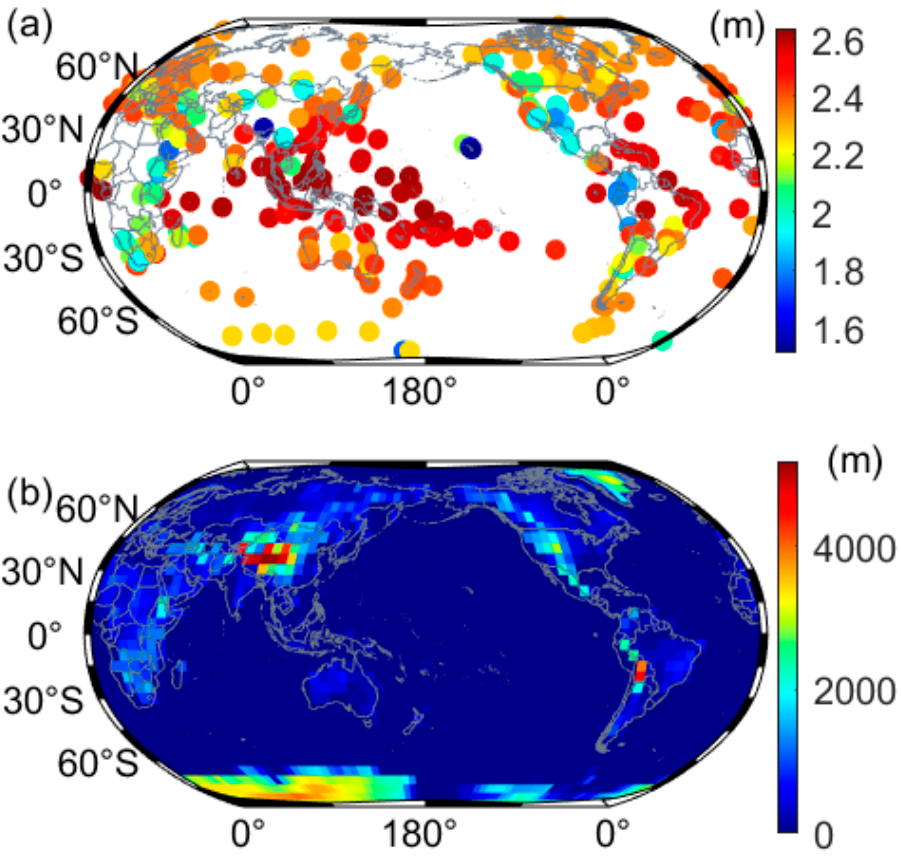
Figure 6. ( a ) Global distribution of mean VMF-ZTD in 2020, ( b ) altitude global distribution.